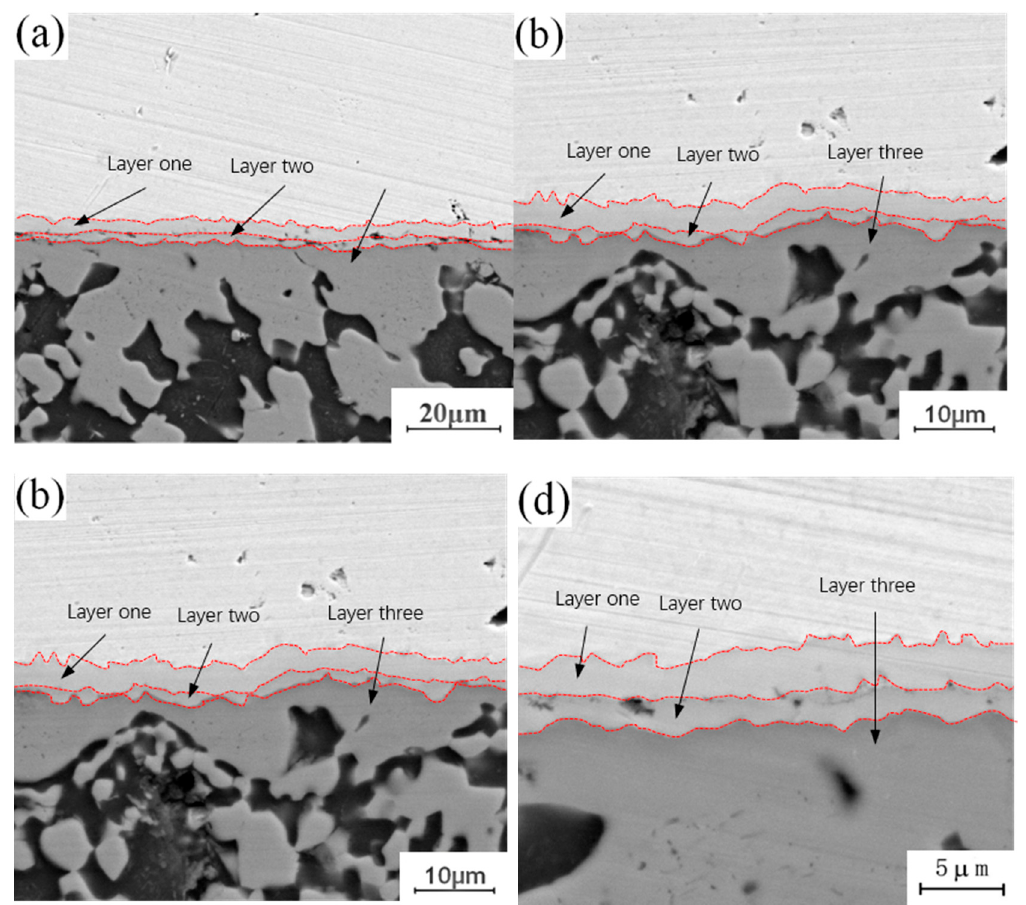
Figure 6. Microstructure of intermetallic compound (IMC) layer annealed at 400 °C for different holding times: ( a ) t = 0.5 h; ( b ) t = 1.5 h; ( b ) t = 3.5 h; ( d ) t = 4.5 h. times: ( a ) t = 0.5 h; ( b ) t = 1.5 h; ( b ) t = 3.5 h; ( d ) t = 4.5